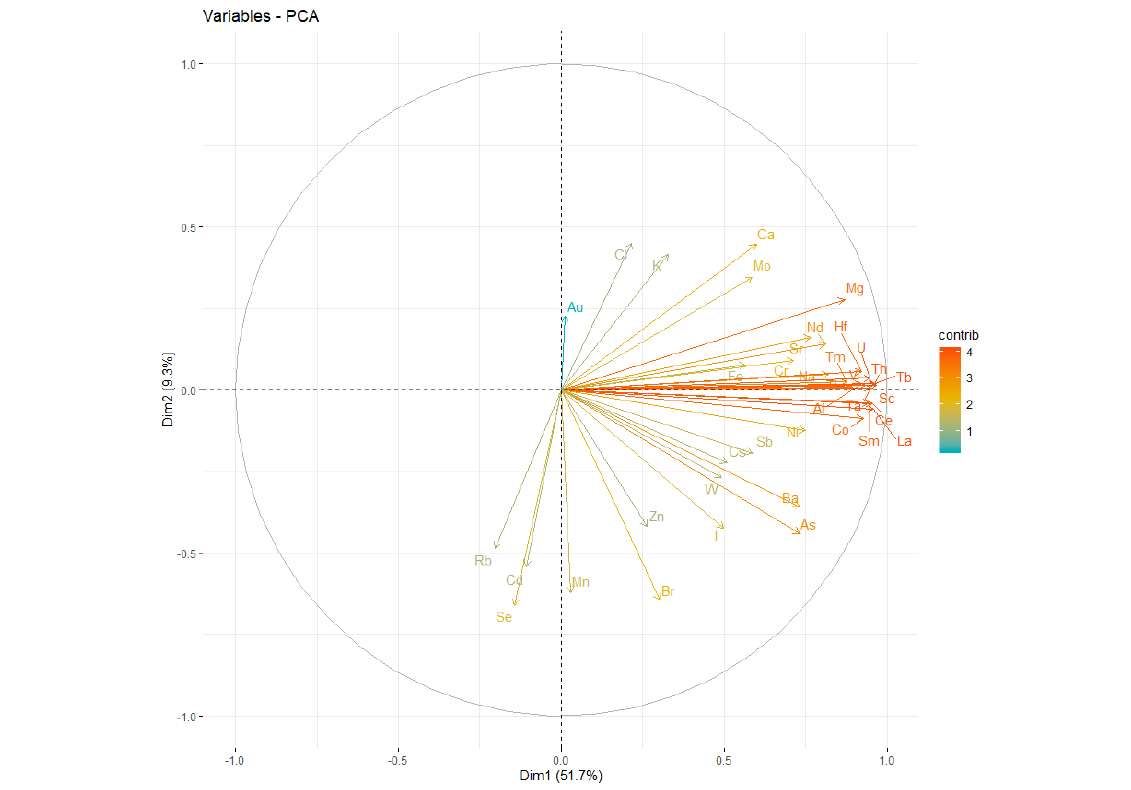
Figure 6. Plot Components Weigh of individual elements.